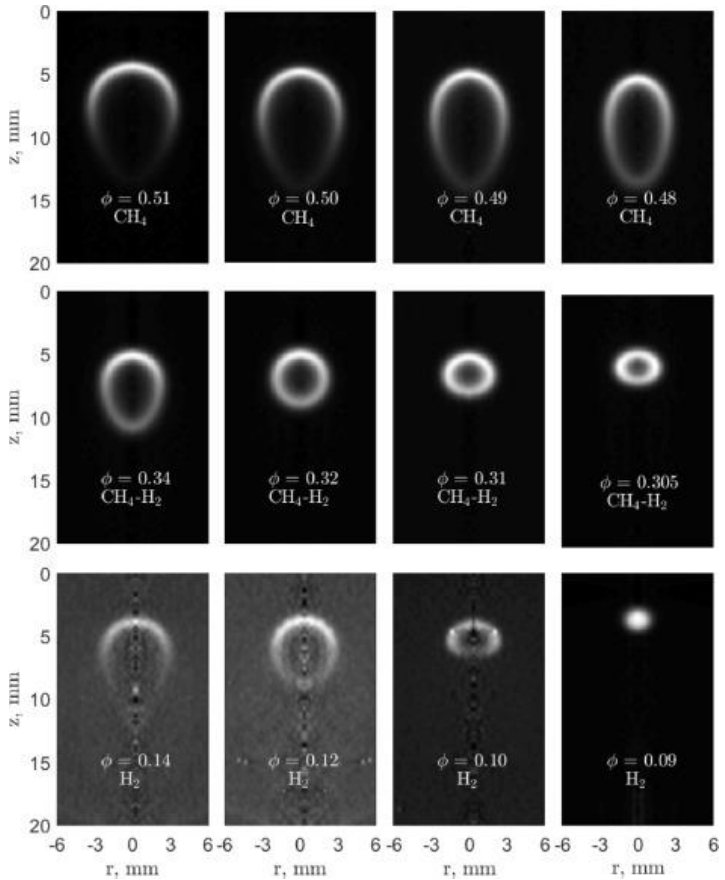
Figure 13. The Abel-inverted CH * chemiluminescence contours for CH 4 -air and 40%H 2 + 60%CH 4 -air flames and OH * chemiluminescence contours for H 2 -air flames with decreasing equivalence ratio [22]. Table 7. Prediction of lower flammability limit (LFL) (equivalent ratio) for di ff erent types of flame with di ff erent fuel compositions. The numerical simulation considered thermal radiation Reproduced in Ref. [22], The Combustion Institute: